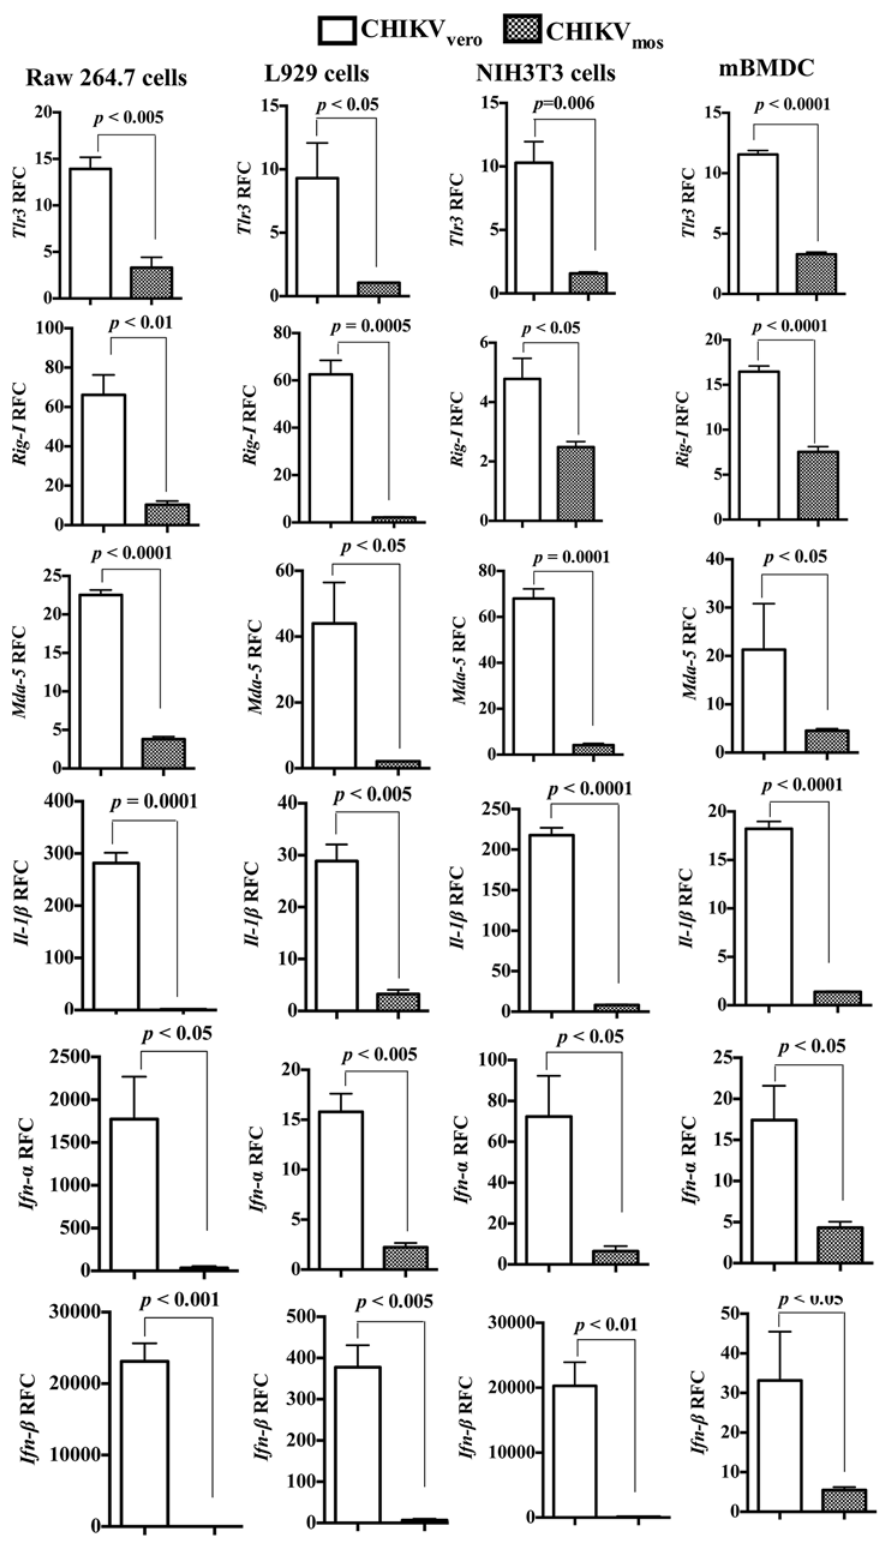
Fig 3. CHIKV mos induces lower antiviral responses than CHIKV vero . Raw 264.7 cells, L929 cells, NIH3T3 cells, and mouse bone marrow derived dendritic cells (mBMDC) were infected with CHIKV vero or CHIKV